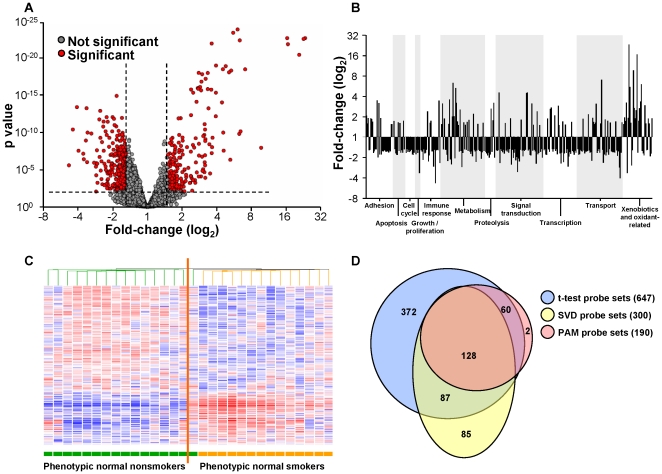
Differential gene expression profiles in the small airway epithelium in nonsmokers and healthy smokers.Expression levels normalized by array were compared for n = 58 healthy smokers and n = 47 healthy nonsmokers for all probe sets “present” in at least 20% of samples. A. Volcano plot. The mean expression level for healthy smokers vs healthy nonsmokers was assessed for fold-change (abscissa) vs p value (ordinate) by t-test. Each probe set is represented by a filled circle, with probe sets that are not significantly different in healthy smokers compared to healthy nonsmokers in gray and those that are significantly different in the 2 groups in red. Probe sets with a higher expression level in healthy smokers are to the top right and those with a lower expression level in healthy smokers are to the top left. There are 647 probe sets representing 375 known genes that are significantly up- and down-regulated by smoking. Only probe sets corresponding to known genes were used to construct the index for small airway epithelium gene expression (ISAE). When there is more than one probe set for a given gene, the decision as to which probe set is used for further analysis was made as described in Methods. B. Categories of genes differentially modified by smoking in the small airway epithelium. Shown is a skyscraper plot of fold-changes (log2 scale) for probe sets significantly differentially expressed in healthy smokers vs nonsmokers. Known genes significantly up-regulated in healthy smokers have fold-changes >1; those significantly down-regulated in healthy smokers have fold-changes <1. Alternating gray and white bands highlight the probe sets belonging to specific functional categories. C. Unsupervised cluster analysis. Probe sets expressed above average are represented in red, below average in blue, and average in white. Each row represents one of the 375 smoking-responsive genes used in the index, and each column represents an individual subject from the validation set of healthy nonsmokers and healthy smokers. Healthy smokers (n = 14) are indicated by orange, healthy nonsmokers (n = 16) by green. D. Venn diagram. Smoking-responsive probe sets identified by the main, t-test analysis (647 probe sets) are represented in blue, probe sets identified by singular value decomposition (SVD, 300 probe sets) in yellow, and probe sets identified by prediction analysis of microarrays (PAM, 190 probe sets) in pink. The intersection of the ovals represents the overlap between genes selected using each method, i.e., 87 genes are smoking-responsive in the t-test and SVD analyses (green), 60 probe sets overlap between the t-test and PAM analyses (purple), and 128 genes were significant in all 3 analyses (brown).